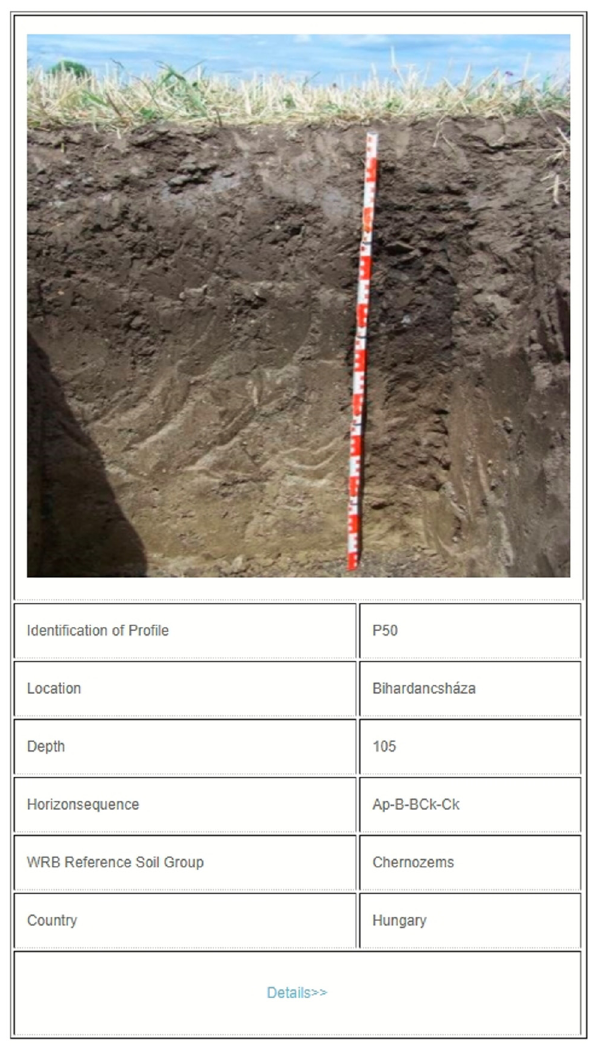
Figure 7: Description of listed soil pro fi le ( source: Balla et al. 2016 )